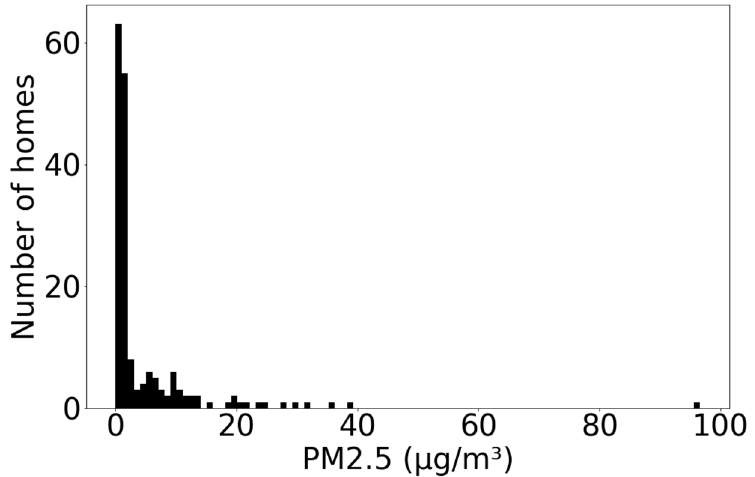
Figure 3. Mean annual indoor PM 2.5 concentrations (µg/m 3